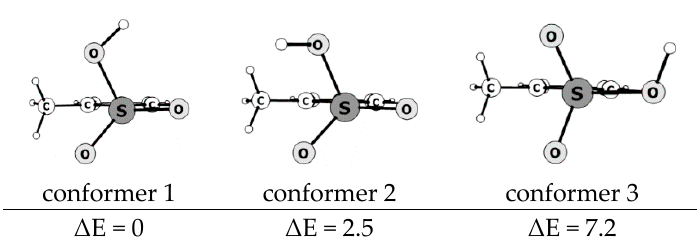
Figure 6. The structure of the 2-CH 3 -BSA conformers and their relative energies ( Δ E, kJ mol − 1 ).